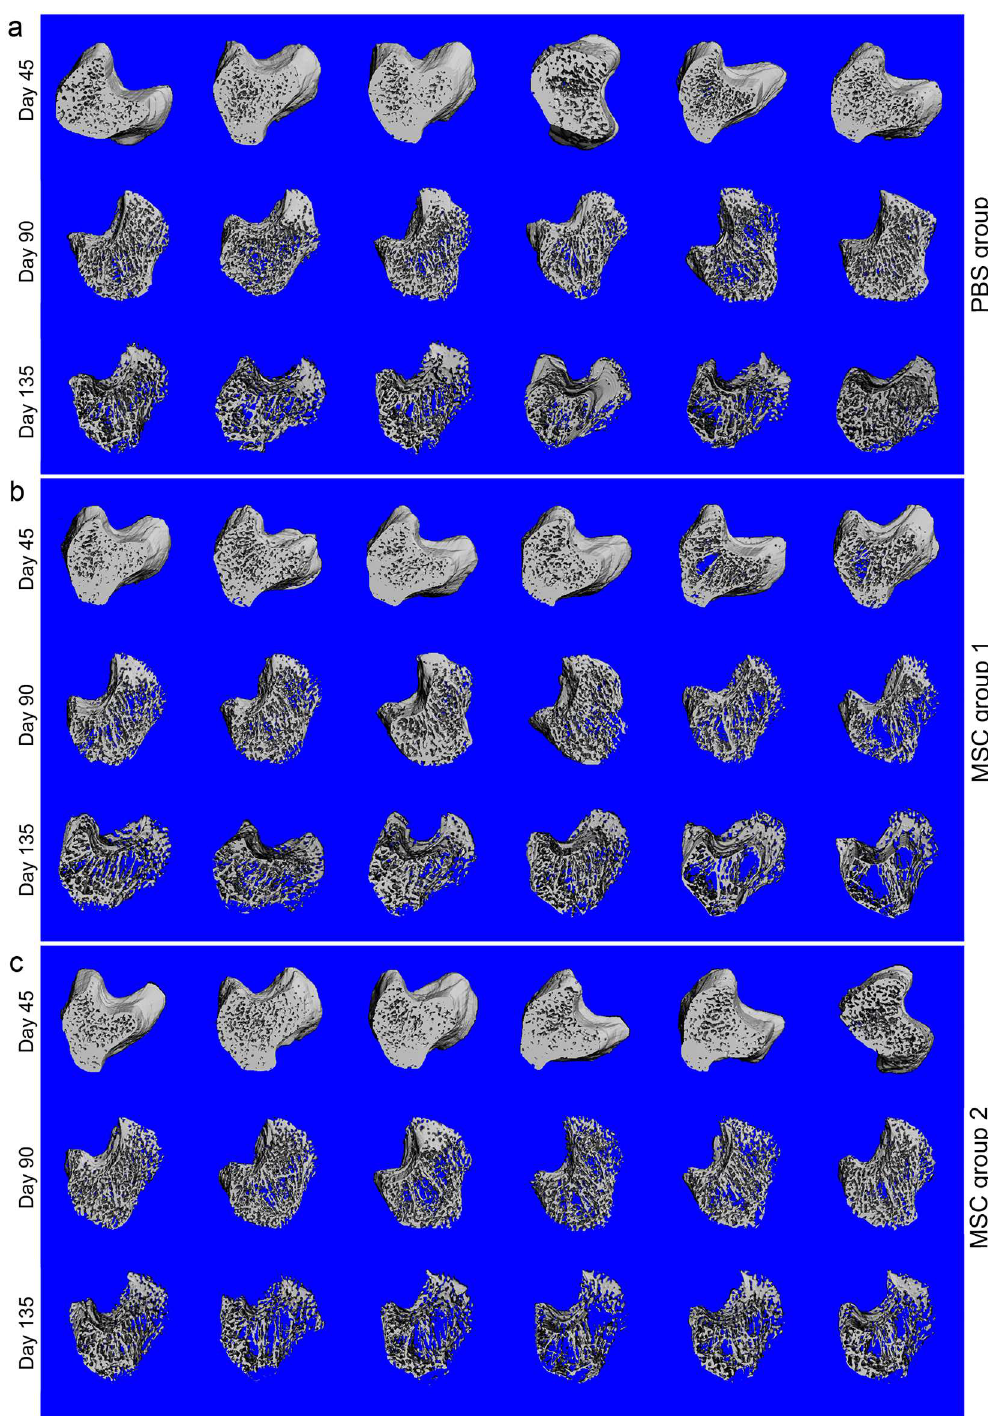
Fig 2. 3D-Reconstruction images of the trabecular bone by Micro CT. All rats were scanned in vivo by Micro- CT at day 45, 90 and 135 followingOVX; the morphology of trabecular bones showed that the trabecular bones were lost graduallywith time after OVX in all samples, but no obvious morphological differences were found among the PBS group (a), MSC group 1 (b) and MSC group 2 (c).